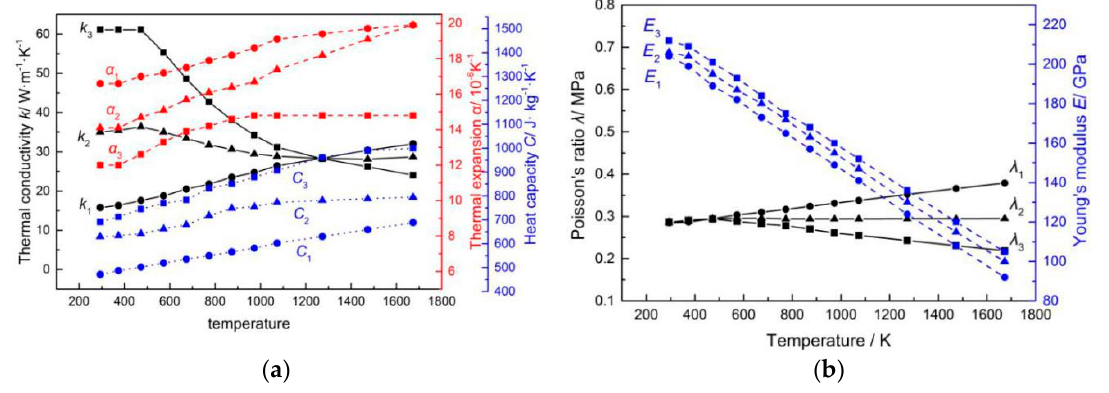
Figure 3. Material parameters of stainless steel and carbon steel: ( a ) Thermodynamic properties; ( b ) mechanical properties.